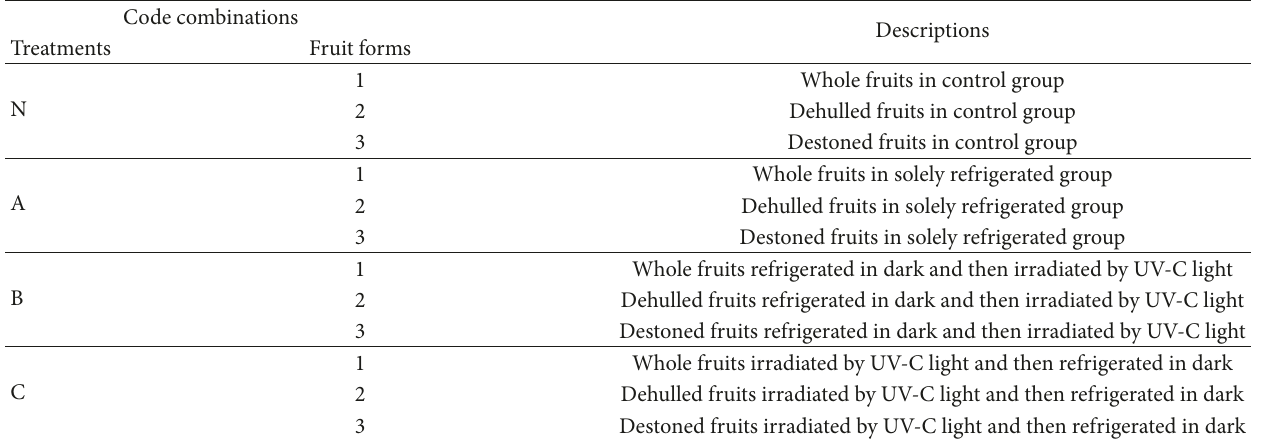
Table 1: Group and subgroup codes with corresponding